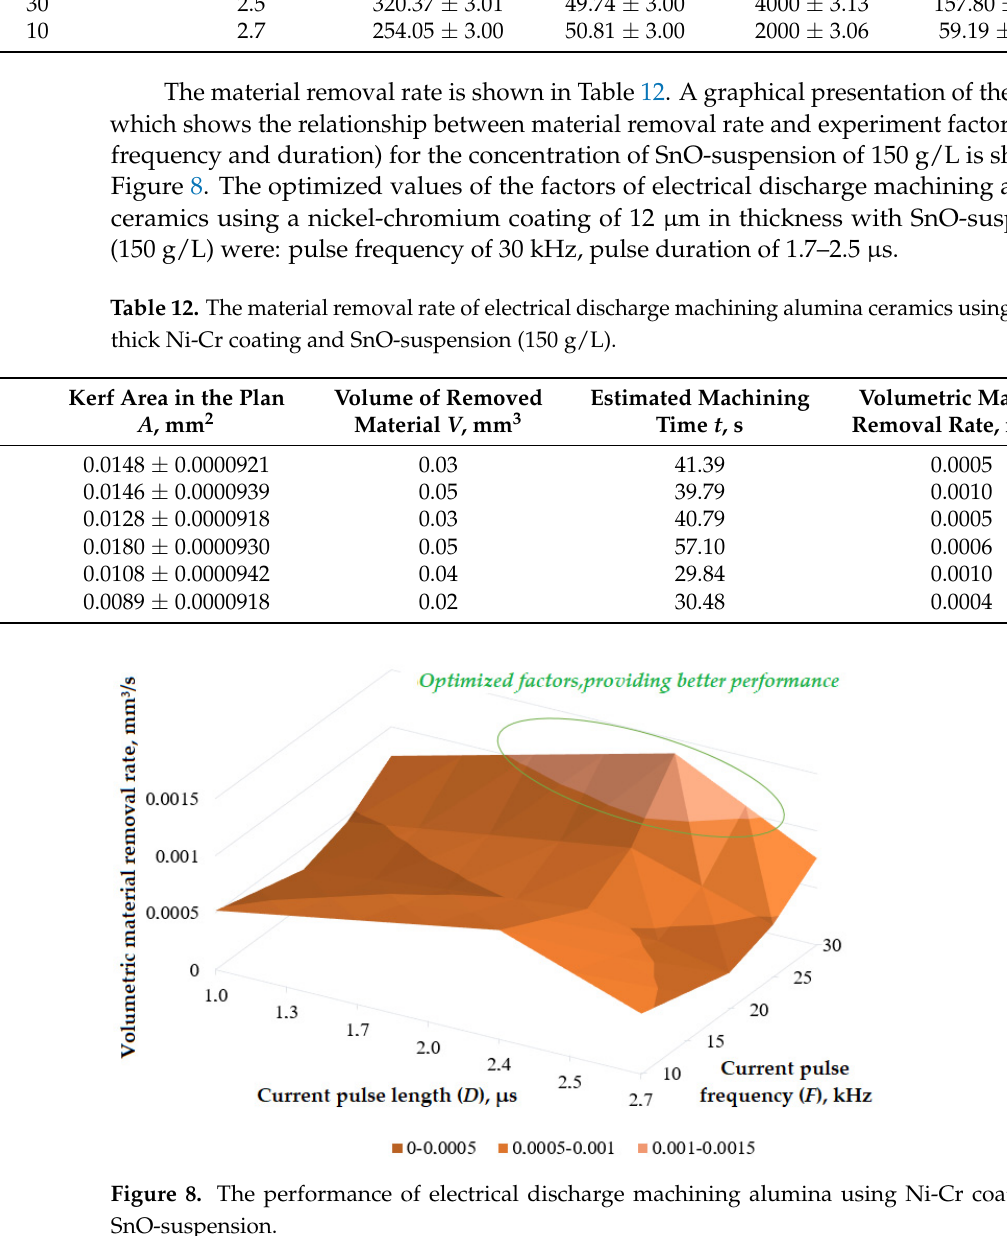
Table 11. The average measured kerf parameters for each factor-set and discharge gap of the ma- chined alumina using a 12 µm thick Ni-Cr coating and SnO-suspension (150 g/L).